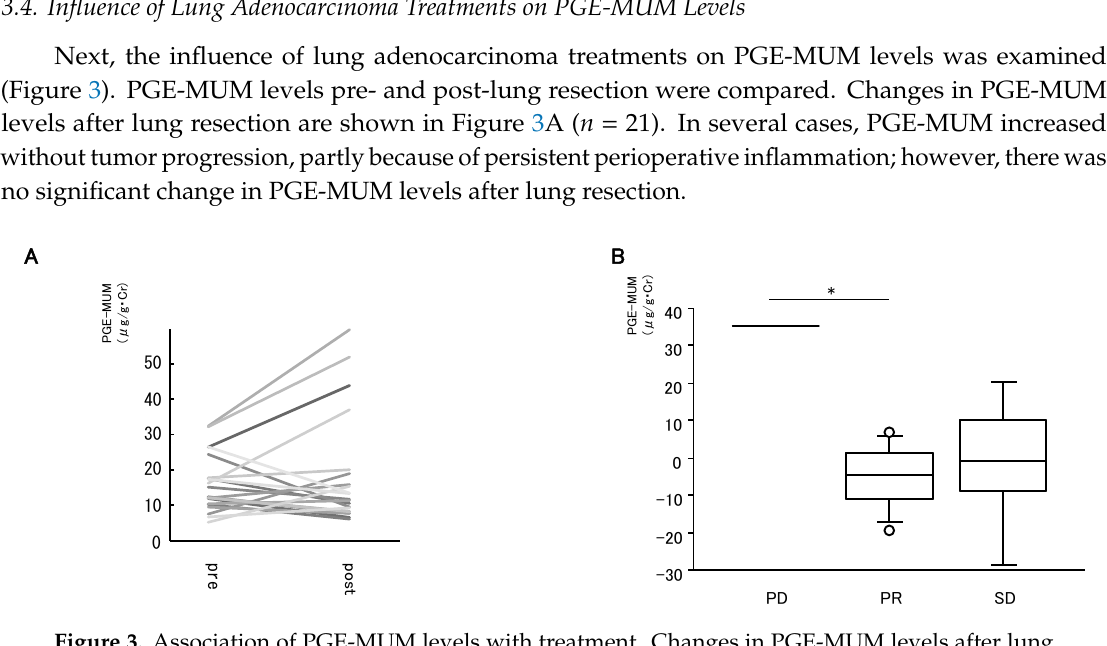
Table 2. Univariate analysis of clinical factors association of with high PGE-MUM. The effects of clinical characteristics (age, sex, BMI, smoking history, advanced stage, and use of a COX-2 inhibitor) on PGE-MUM levels were examined.